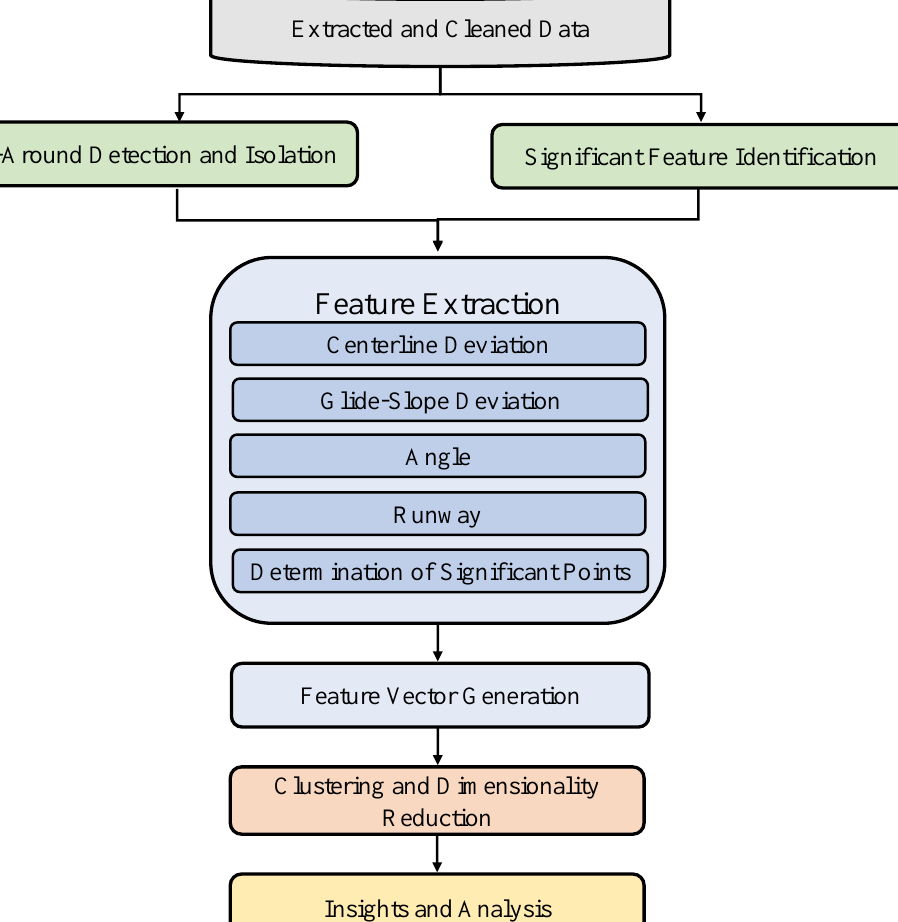
Figure 1. Methodology